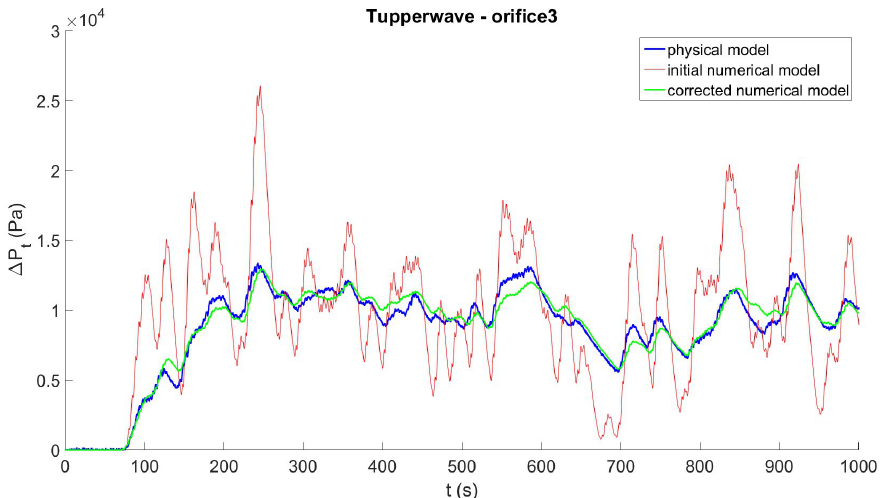
Figure 4. Pressure drop time series (given at full-scale equivalence) across Orifice 3 of the Tupperwave device obtained by the physical model, the initial numerical model, and the corrected model in the scaled irregular sea state equivalent to { Hs = 3 m; Tp = 8.5